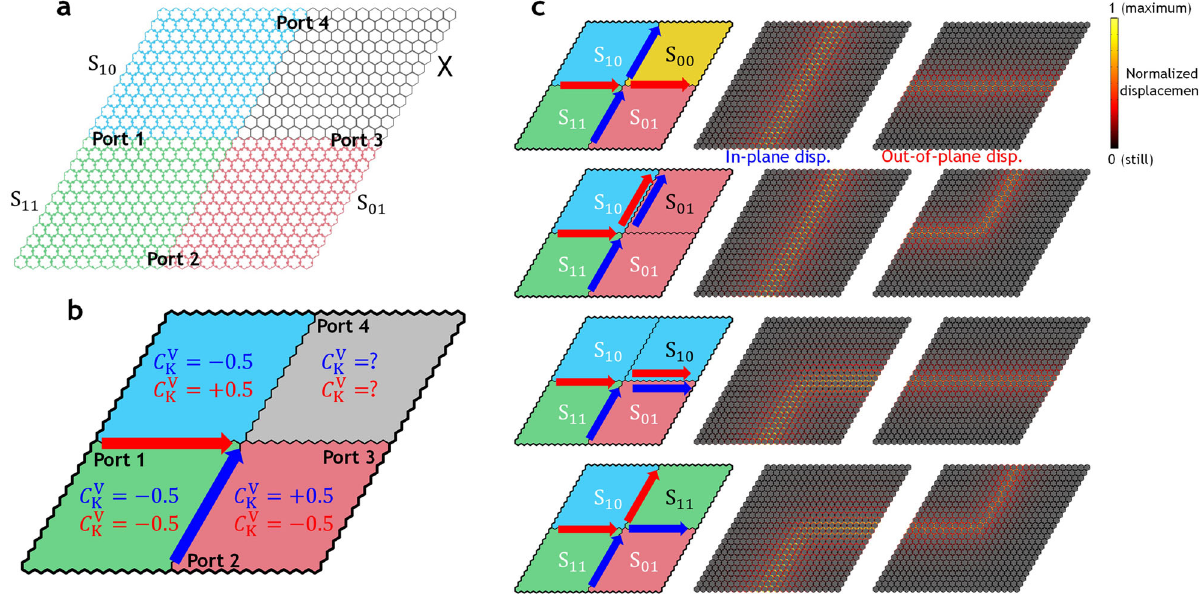
Fig. 7 Independent and simultaneous steering of in-plane polarized (IPP) and out-of-plane polarized (OPP) wave. a Con fi guration of phononic crystals (PCs) made of S 10 , S 01 , S 11 , and undecided X for independent control of IPP and OPP wave. b Schematics of IPP and OPP wave input. IPP and OPP waves of 30 kHz are injected through ports 2 and 1 respectively, where ideal valley Chern numbers at valley K of each PCs are present to support the existence of the corresponding edge states. c In-plane and out-of-plane wave trajectories and displacement fi elds of the con fi guration for X = S 00 , S 01 , S 10 , and S 11